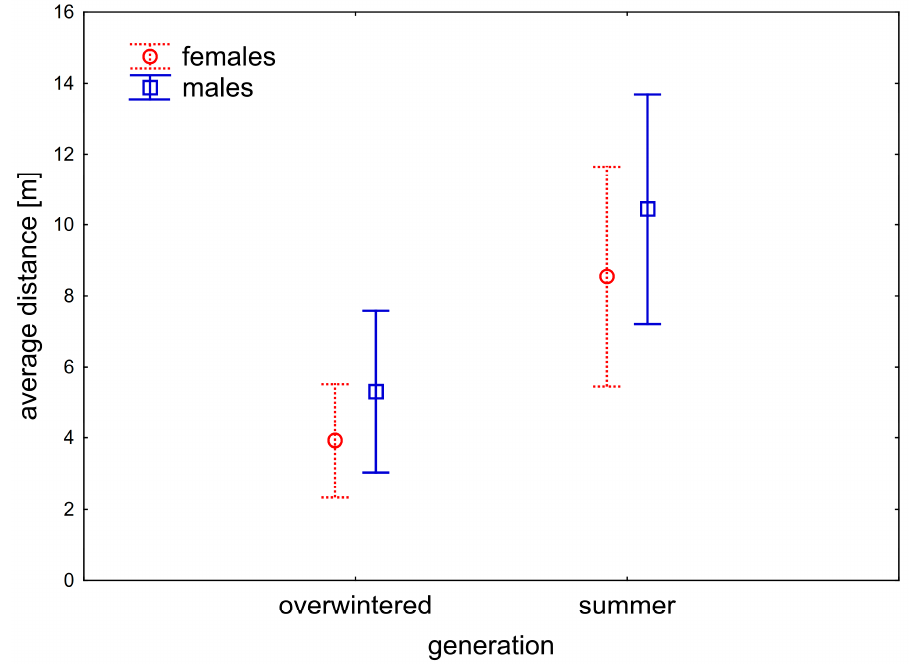
Figure 10. A relation of the movement and generation of V. caprai . The summer generation moves significantly further than an overwintered generation; this pattern is similar for both sexes. Vertical bars denote 0.95 confidence intervals.